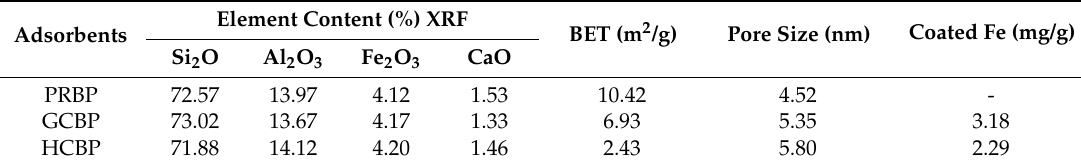
Table 1. The properties of pickling red brick particles (PRBP), goethite-coated brick particles (GCBP), and hematite-coated brick particles (HCBP).